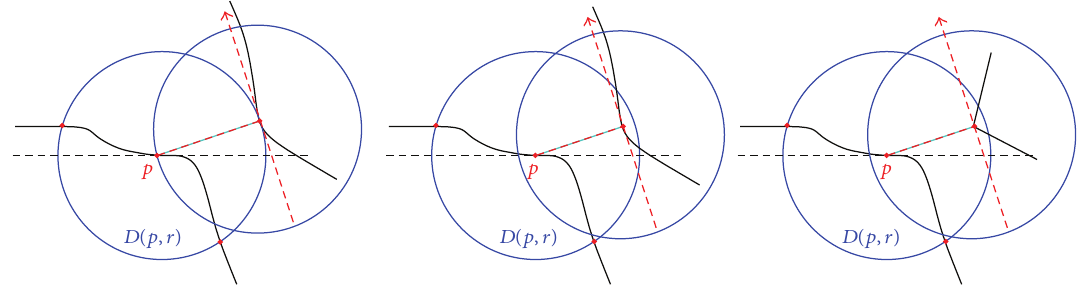
Figure 4: Additional points of intersection violate the TCGL condition.